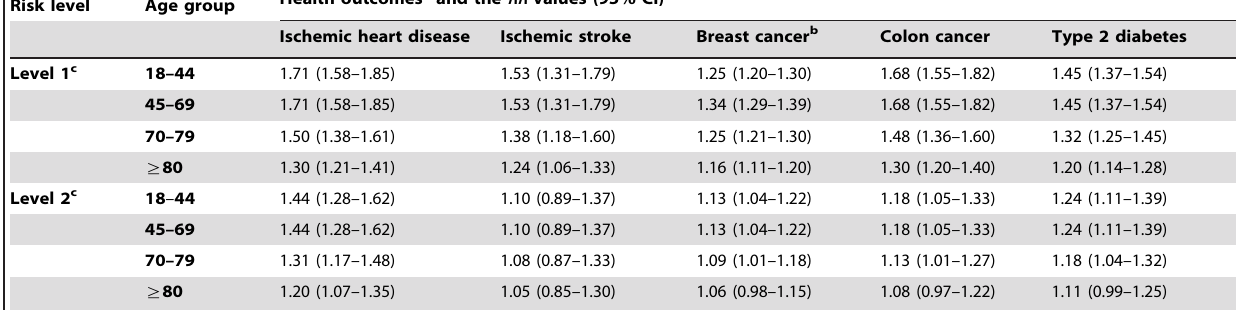
Table 2. RR values (95% CI) for selected health outcomes by